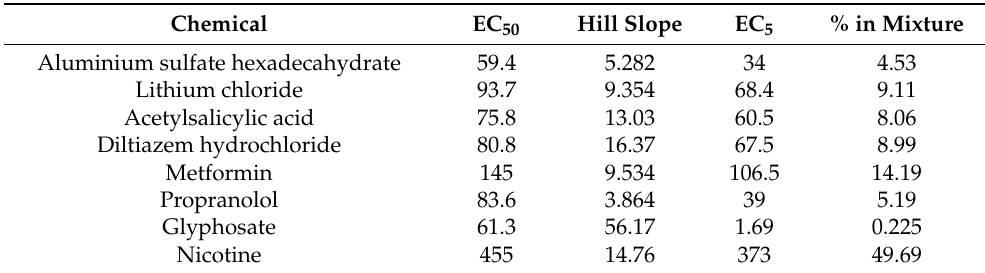
Table 1. EC values (in mg/L) from toxicity curves and mixture ratio at EC 5